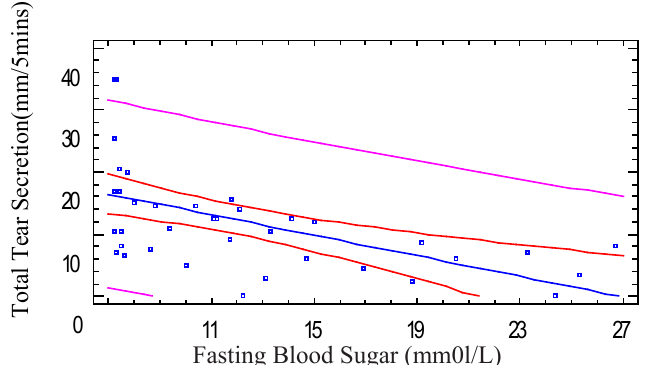
secretion)Fasting Blood Sugar Figure 1: Relationship between fasting blood sugar and total tear secretion in the NIDDM group. (TTS = Total tear secretion, BTS =Basal tear